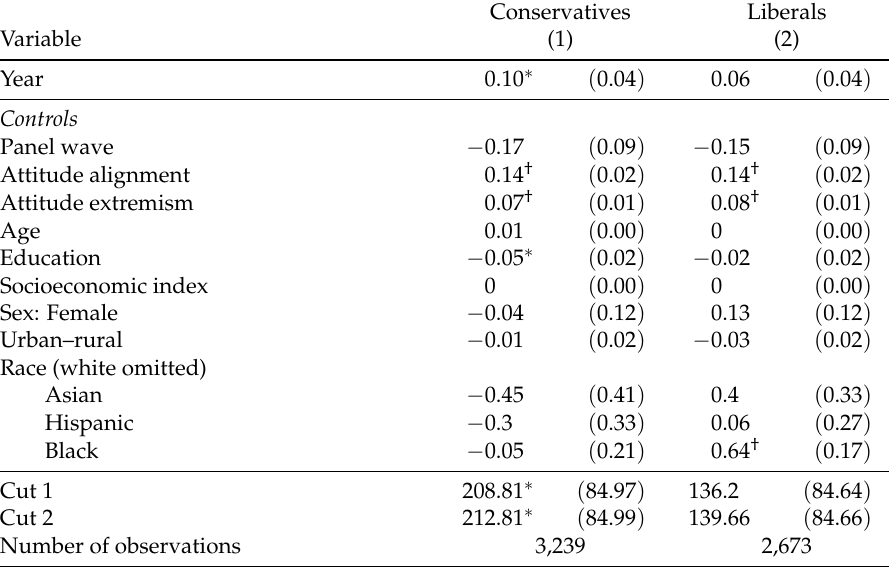
Table 3: Hierarchical ordered logistic regression models predicting trends in ideolog- ical identity strength, 2006 to